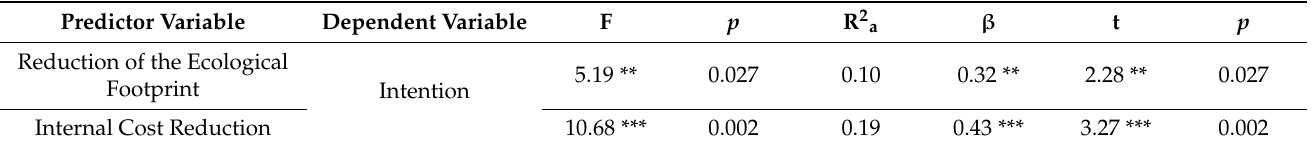
Table 4. Linear Regressions of H2 (Source—IBM SPSS Statistics v.28.0.0.).